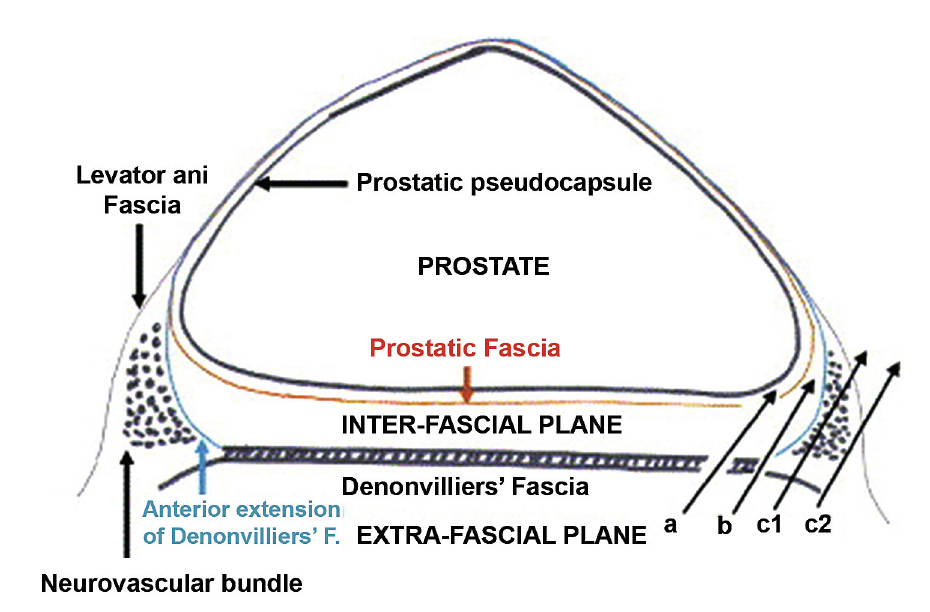
Figure 2 – Axial view of prostatic fascial anatomy. a = intrafascial plane; b = interfascial plane; c1 = extrafascial plane with partial preservation of neurovascular bundle; c2 = extrafascial plane with no preservation of neurovascular bundle. (9) (with permission from Elsevier